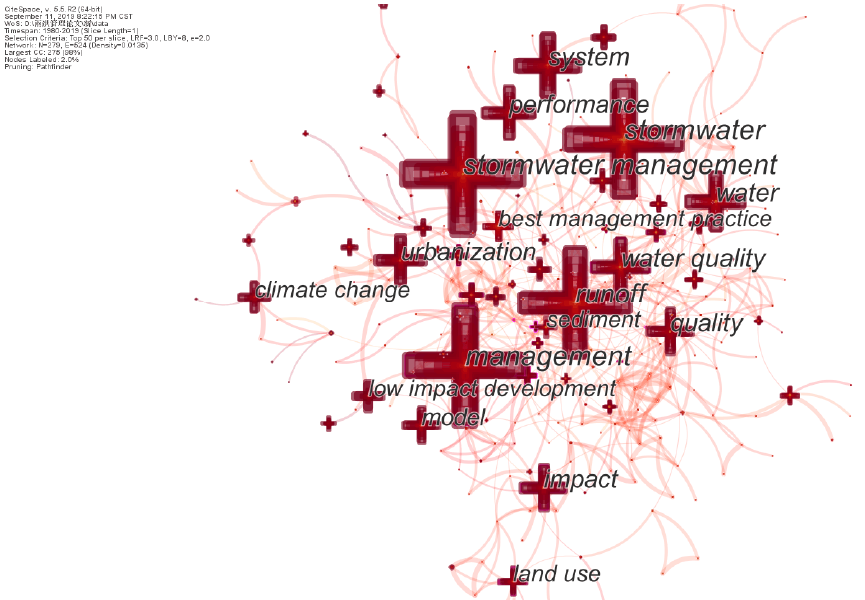
Figure 5. Keyword co-occurrence diagram.